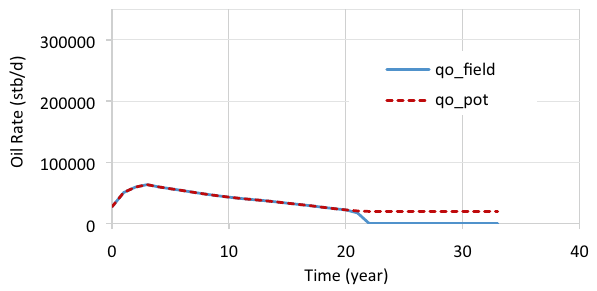
Fig. 6 Optimum oil production profile and oil production potential for strategy TLP with MPB +